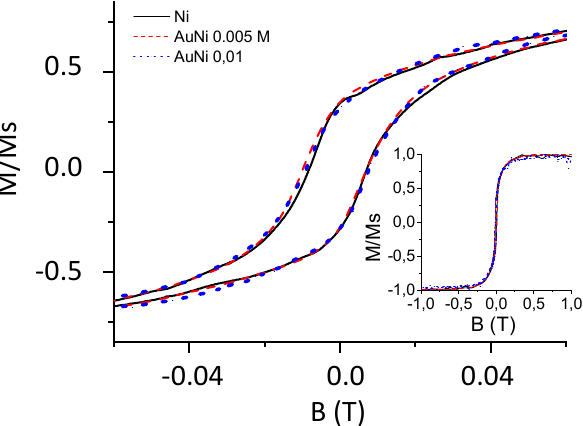
Figure 5. Hysteresis loops of Ni, Ni@Au (0.005), and Ni@Au (0.01) NTs. All the samples for measurements were prepared in the form of powders. Insert shows the magnetization in larger fields saturating the samples.